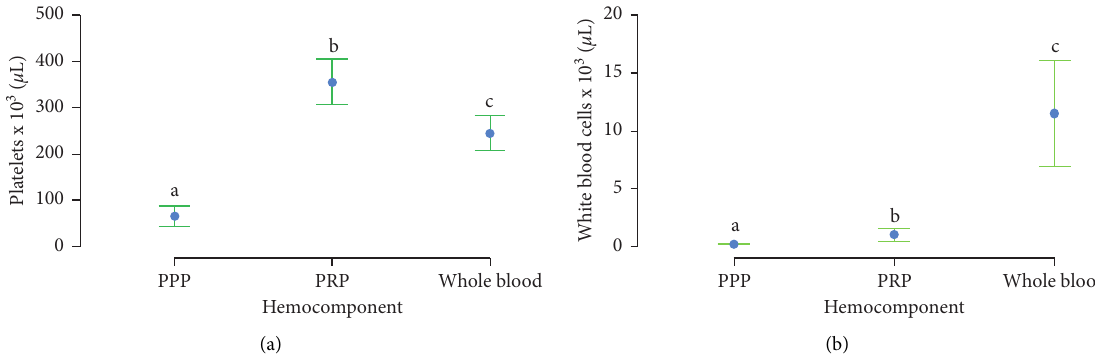
Figure 2: Cell concentrations in whole blood and hemoderivatives. (a) Mean ( ± SD) platelet concentrations in whole blood, PRP, and PPP. (b) Mean ( ± SD) leukocyte concentrations in whole blood, PRP, and PPP. Different lower-case letters represent significant ( P < 0 . 05 ) differences between hemocomponents for platelet and leukocyte concentration. HA, hyaluronan; IL, interleukin; LPS, lipopolysaccharide; PLT, platelet; PDGF-BB, platelet-derived growth factor isoform BB; PPP/PPGS, platelet-poor plasma/platelet-poor gel supernatant; PRP/ PRGS, platelet-rich plasma/platelet-rich gel supernatant; TGF- β 1 , transforming growth factor beta 1; WBC, white blood cell.